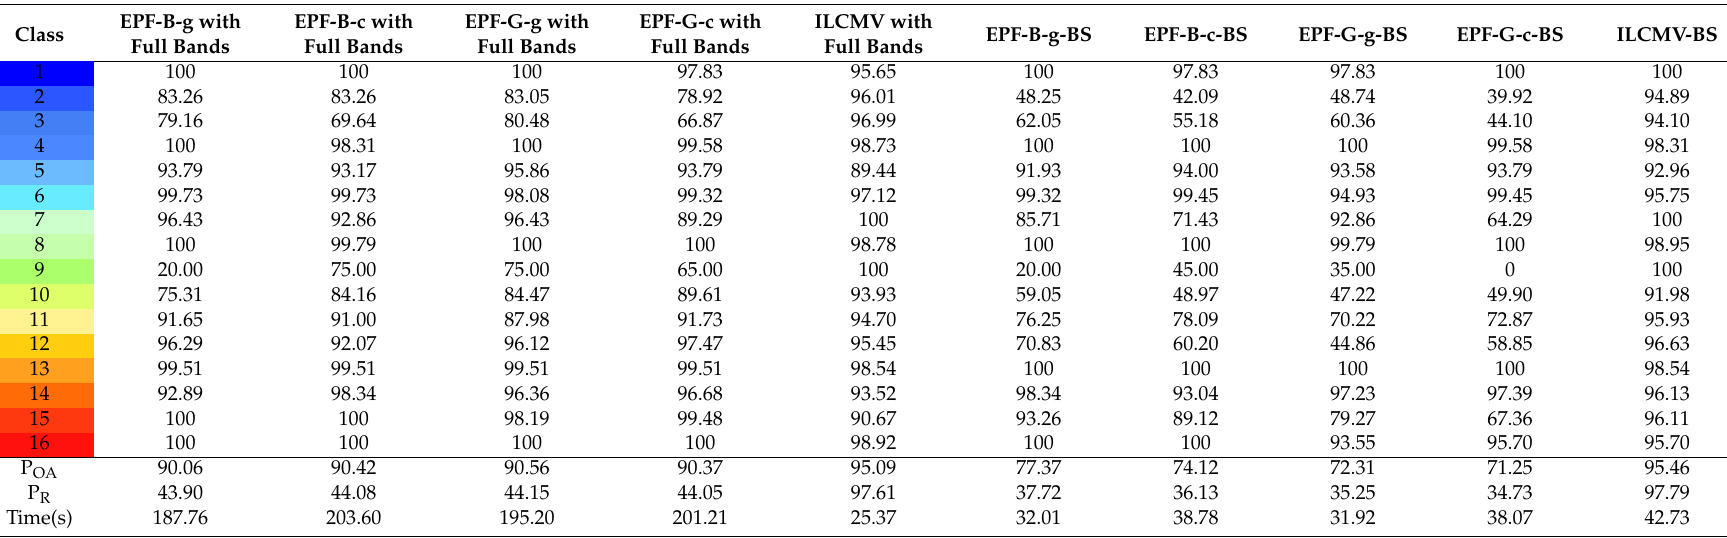
Table 9. P OA and P R calculated by the classification results using full bands and the bands selected by SC LCMV-BSS for the Purdue data.